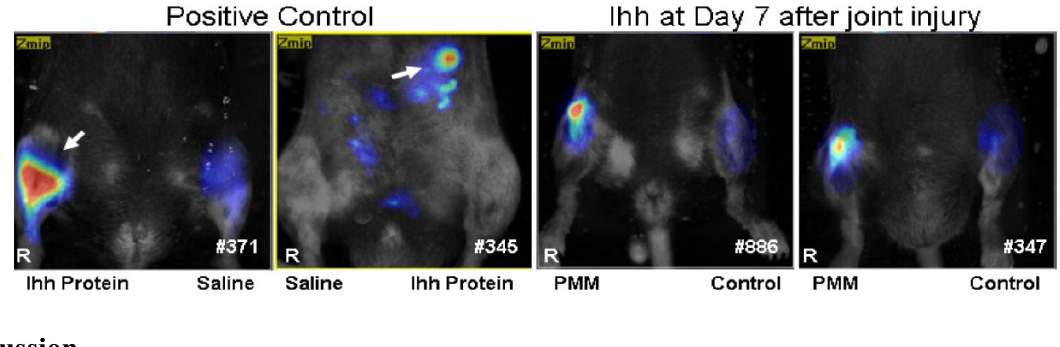
Figure 7. Elevated Ihh was also validated by Fluorescence Molecular Tomography (FMT) in our mouse partial medial meniscectomy (PMM) surgery-induced OA model. First, we validated whether Ihh-FMT probe can detect Ihh specifically in vivo . Two hundred ng Ihh recombinant protein was injected into right knee join and left belly. We found that a strong positive signal of Ihh was only detected at right knee and left belly (arrow) respectively but not in the saline injected sides (left knee and right belly) 24 h after injection (#371 and #345). A positive signal of Ihh was also detected at day 7 after right knee subjected to PMM joint injury but not in the left control knee (right two animals: #886 and #347, n = 5); R, right